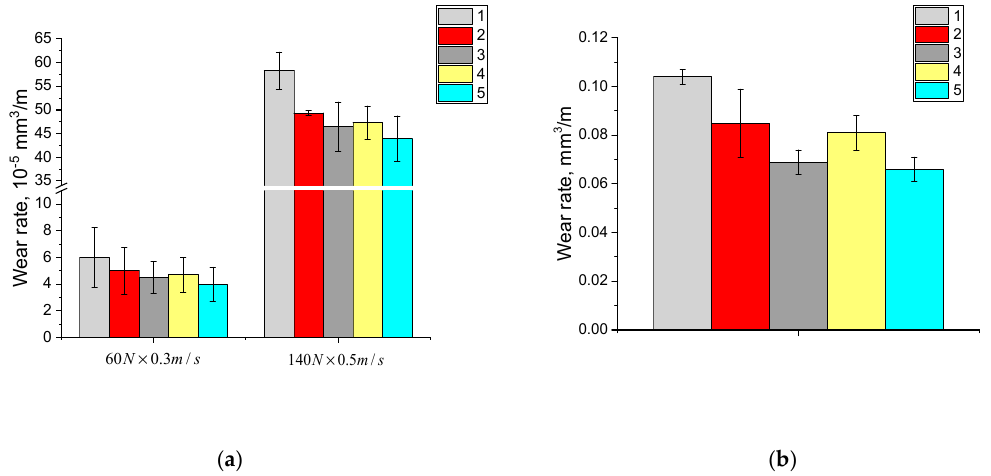
Figure 9. Diagrams on wear rates at dry sliding friction ( a ) and abrasive wear ( b ): 1—neat 4022-6; 2—“GUR 4022-6 + 10% MGF annealed” composite; 3—“GUR 4022-6 + 10% MGF annealed and treated with “KH-550”” composite; 4—“GUR 4022-6 + 10% LGF annealed” composite; 5—“GUR 4022-6 + 10% LGF annealed and treated with “KH-550””